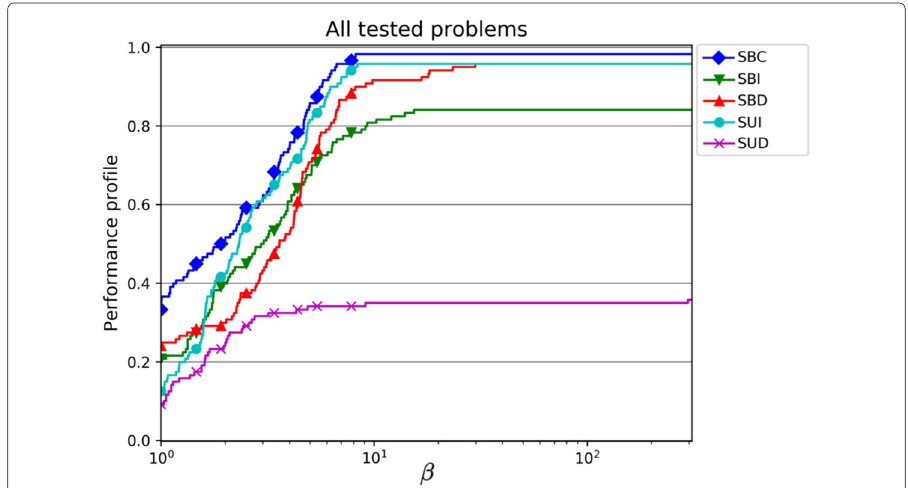
Fig. 11 Performance profile for second order MethodsSBC,SBI,SBD,SUI,SUD , for all performed tests